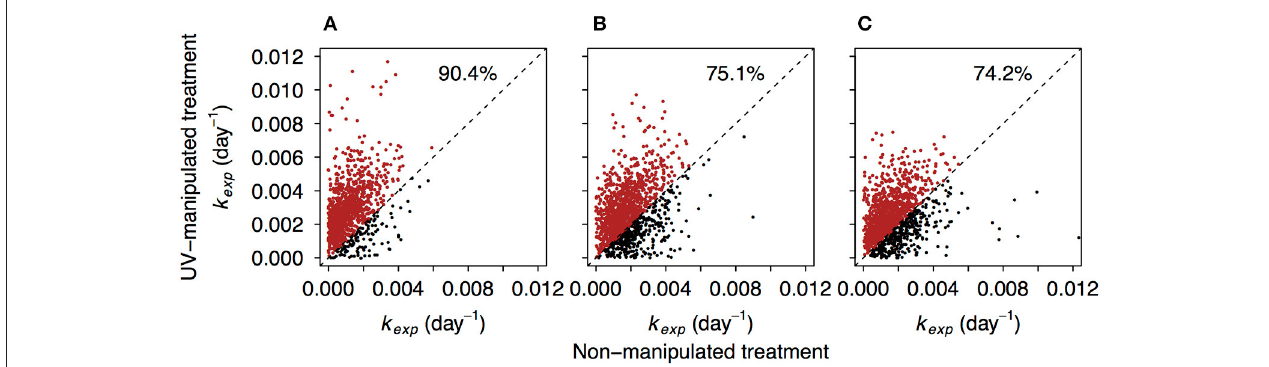
FIGURE 5 | Comparison of decay coefficients k exp of the formulae shared by non-manipulated and UV-manipulated experimental treatments. Dashed line refers to hypothetical 1:1 relationship. The data points above the 1:1 line are depicted in red. Percentages refer to the share of data points above the 1:1 line. (A–C) correspond to lake Lumpen, Ramsjön, and Övre Langsjön, respectively. One of the experimental duplicates is shown in each case (data from the second duplicate is shown in the Figure S7).